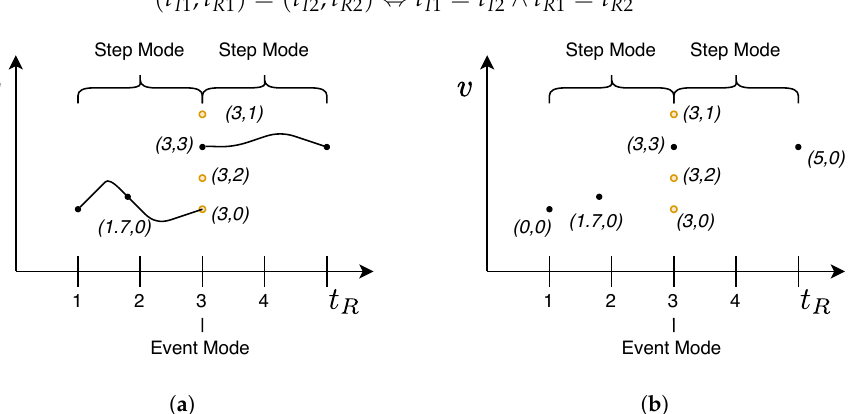
Figure 3. An example of the variable trajectory of the variable v in superdense time. The continuous evolution of v is represented in ( a ) as a line. The dots on the line represent the variable’s value and the time points at which the variable v can be inspected. The yellow dots denote that the FMU is in Event mode, while the black dots denote that the FMU is in Step mode. The evolution of v from the importer ’s perspective is represented in ( b ) as a set of discrete points. ( a ) Trajectory of the variable v in superdense time. ( b ) Trajectory of the variable v from the importer ’s